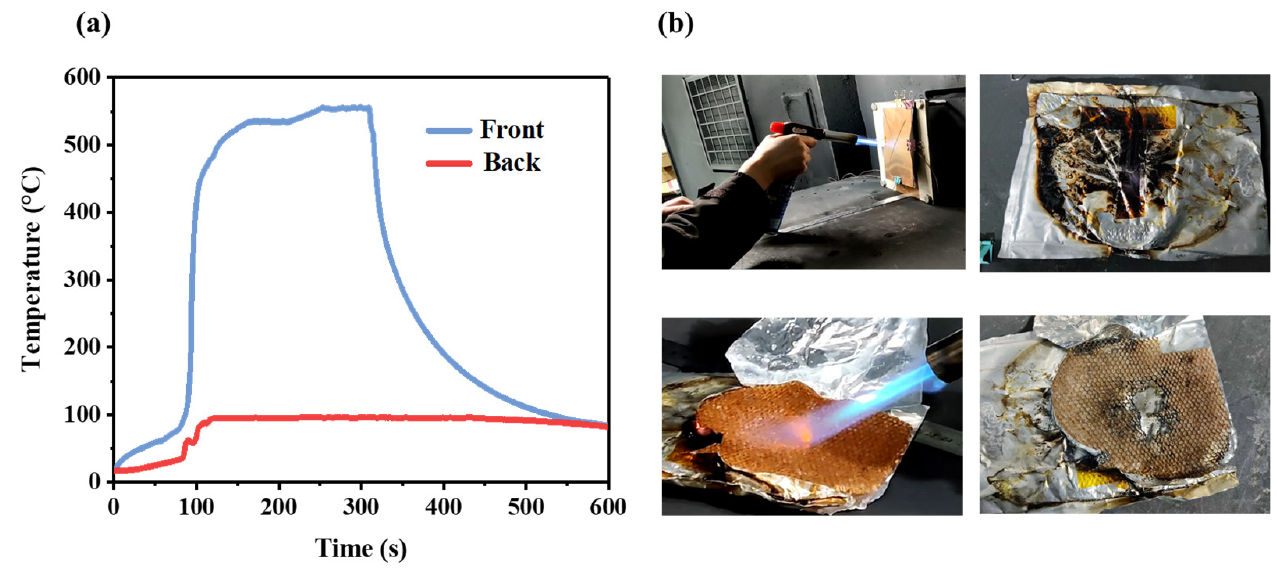
Figure 4. Flame gun test of thermal barrier: ( a ) variations in temperature; ( b ) process of the experi- ment.